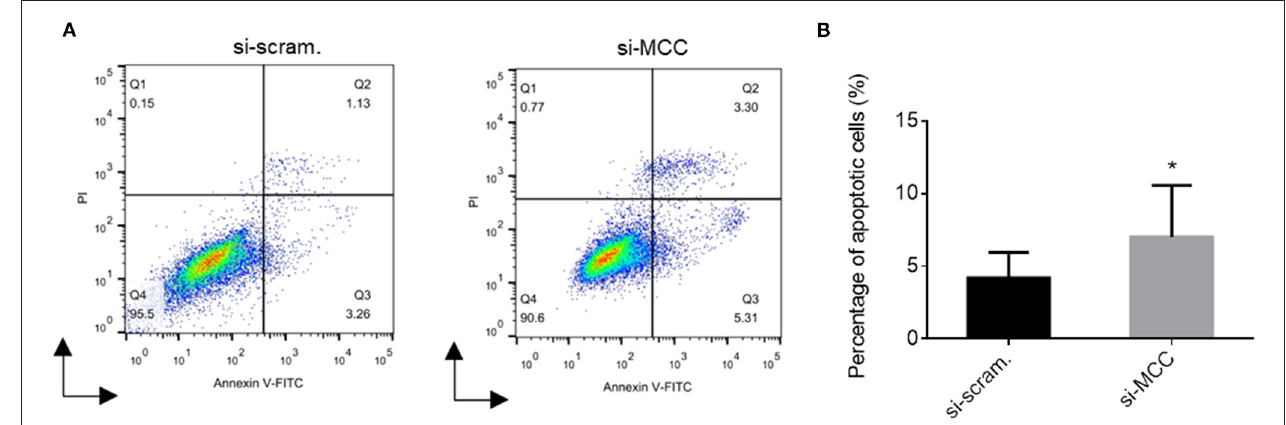
FIGURE 6 | Flow cytometry of Annexin V staining of podocytes treated with scramble control and si-MCC for 72h. (A) Histogram representation of the results of the flow cytometric assay. (B) Quantification of the percentages of the Annexin V positive cells in the samples. The results were obtained from three independent